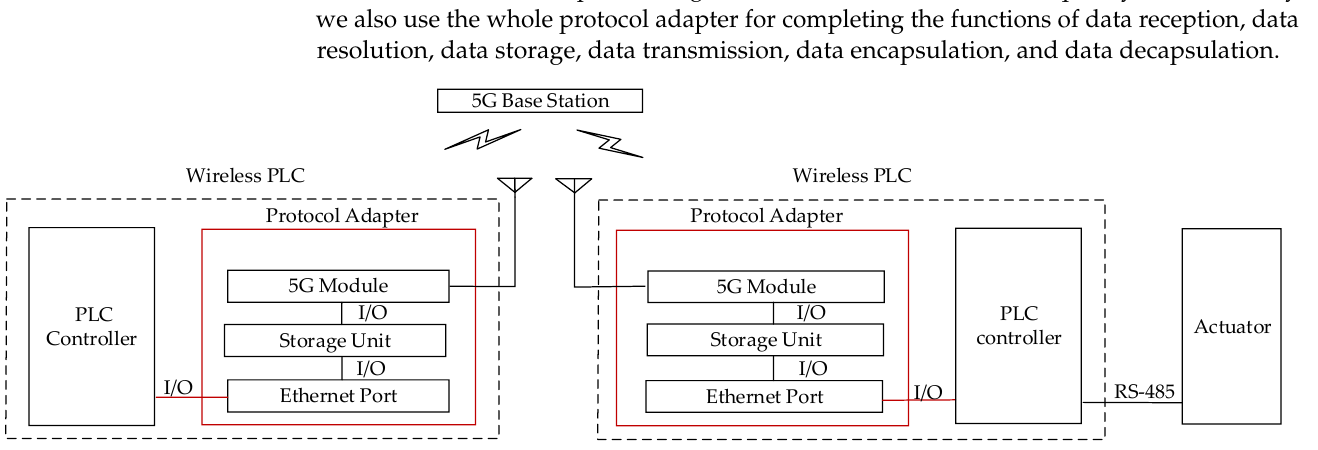
Figure 10. Hardware structure of wireless PLC for Modbus TCP.